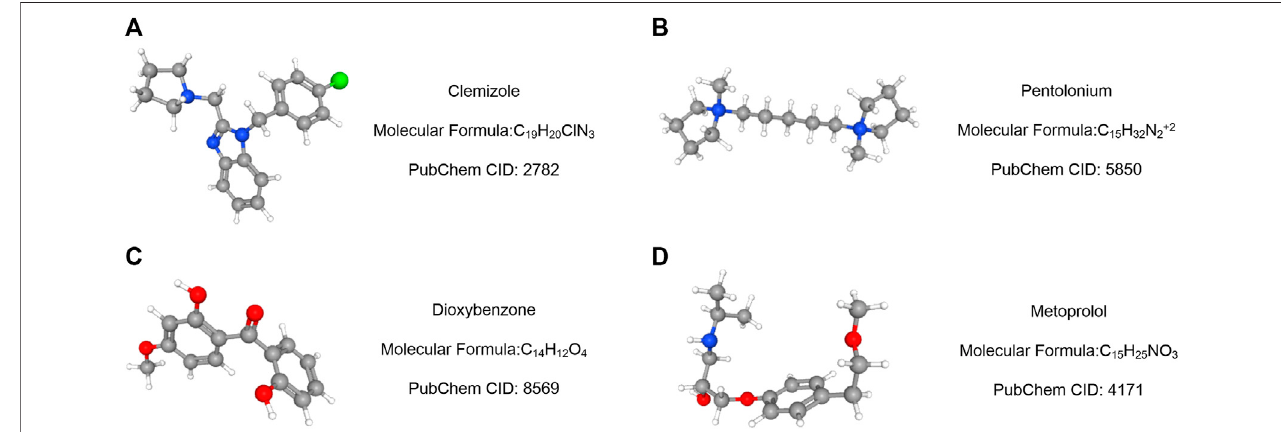
FIGURE 9 | Drug prediction results based on three targeted genes (HAMP, NR3C2, and VAV3). (A – D) Important relative information of the potential drugs.